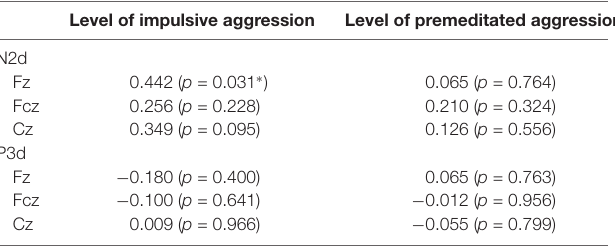
TABLE 2 | Partial correlation between average amplitude of N2d, P3d and aggressive behavior. Level of impulsive